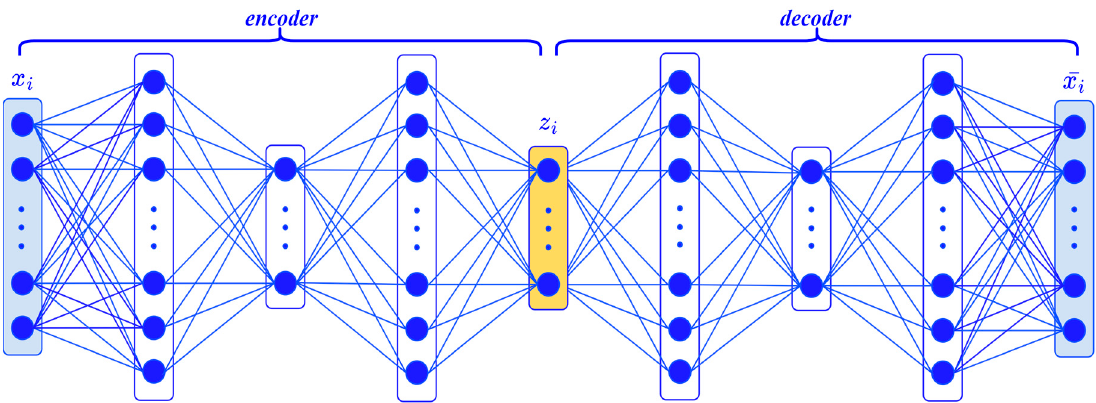
Figure 1. The architecture of the deep-embedded autoencoder.